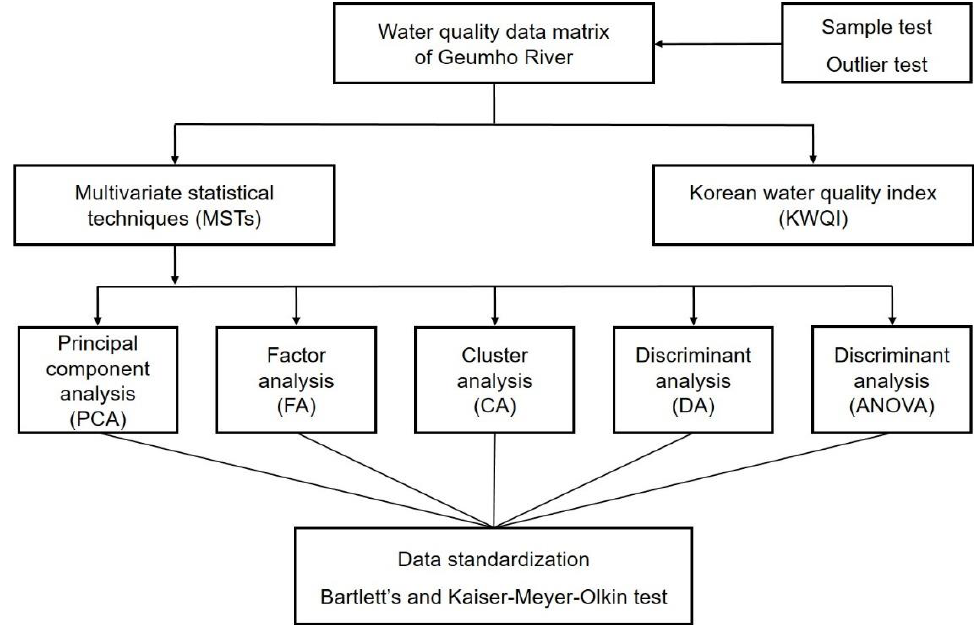
Figure 1. Flow chart of data analysis on the Geumho River.